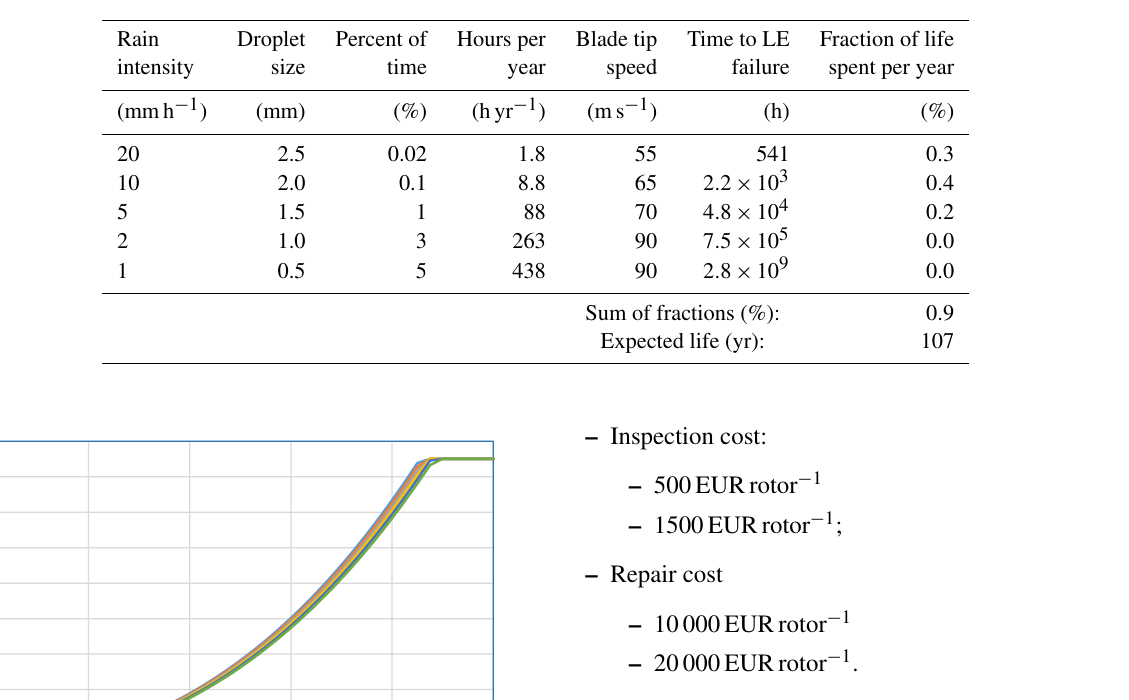
Table 8. Calculation of the expected lifetime of the blade leading edge with a reduction in the tip speed to 55, 65 and 70ms − 1 : Control Strategy 5.